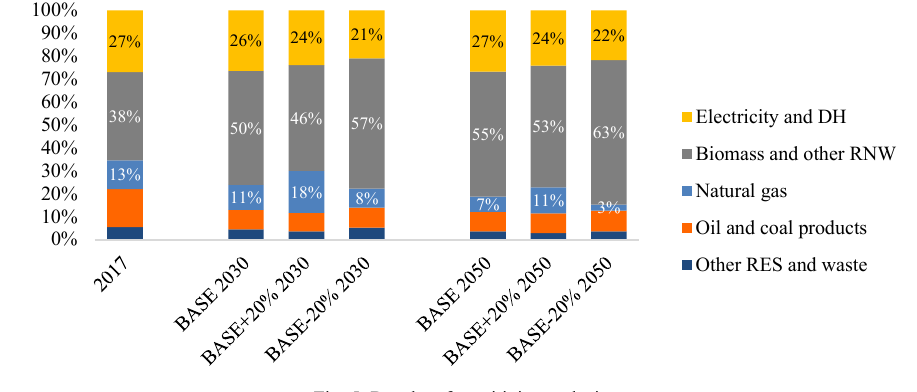
Fig. 5. Results of sensitivity